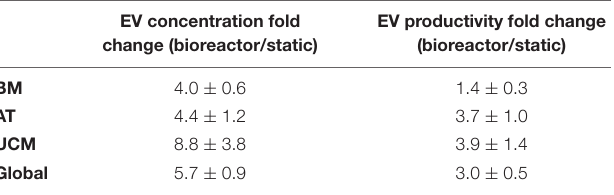
TABLE 2 | Fold changes in EV concentration and EV productivity in the cell culture conditioned medium from the bioreactor system compared to static conditions. EV concentration fold EV productivity fold change change (bioreactor/static)